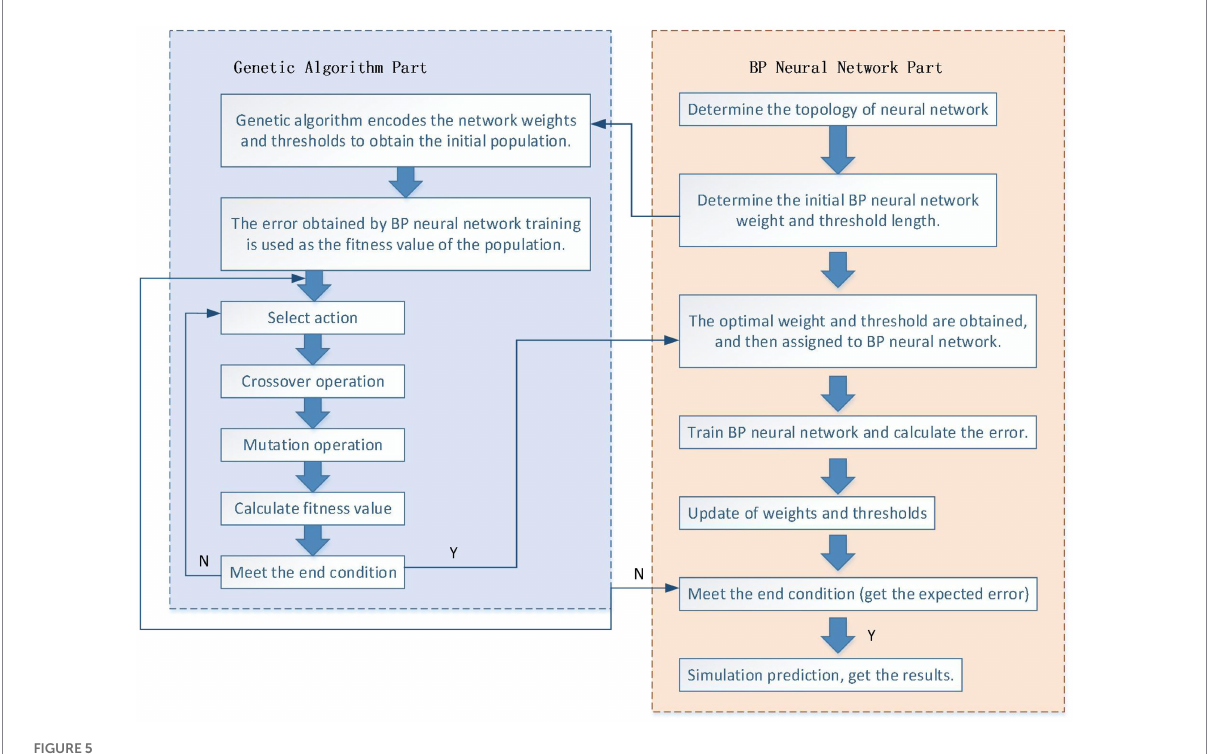
FIGURE 5 Algorithm flow of